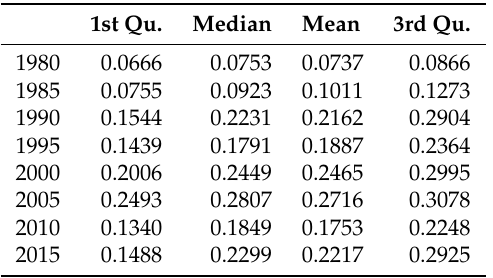
Table 2. Return to education (Step 1) summary